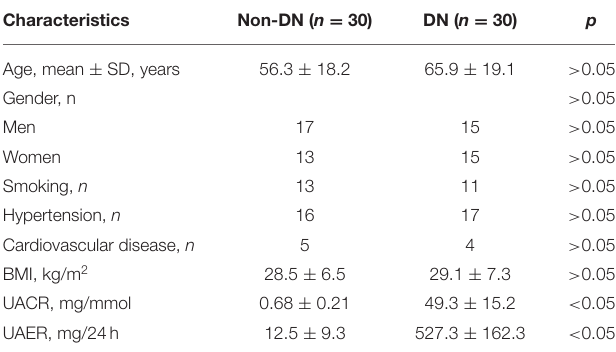
TABLE 1 | Baseline characteristics of patients with DM ( n =